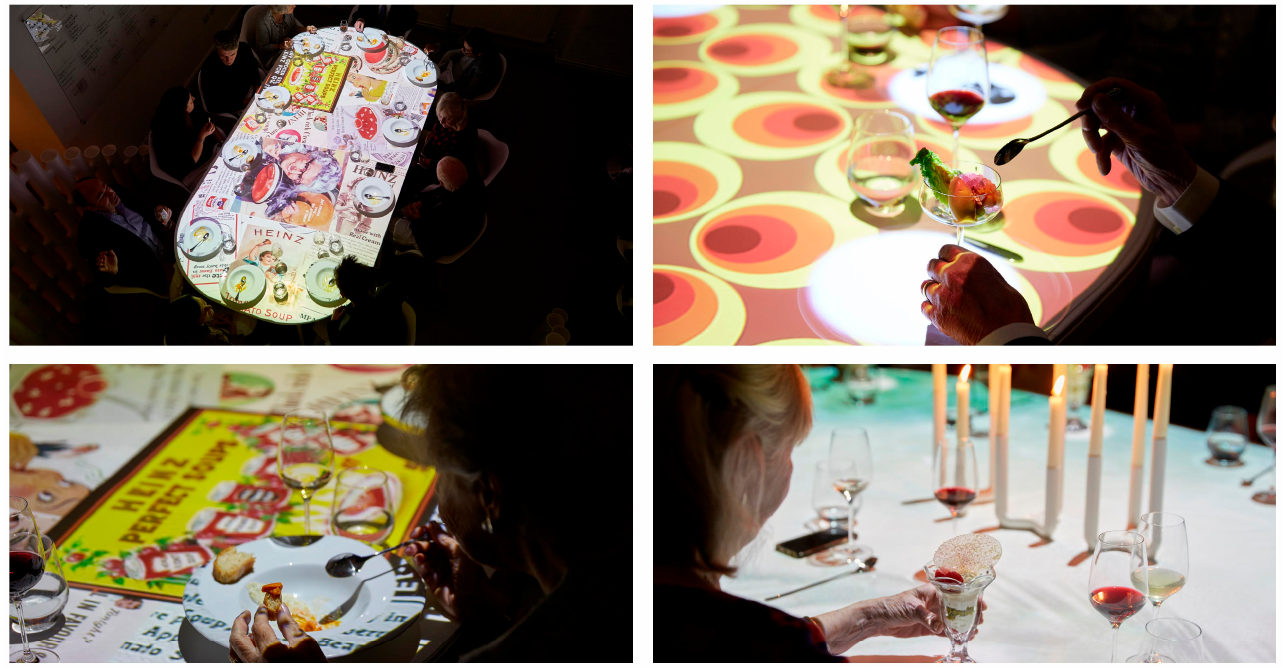
Figure 2. Still images from the Denville Hall dining concept.